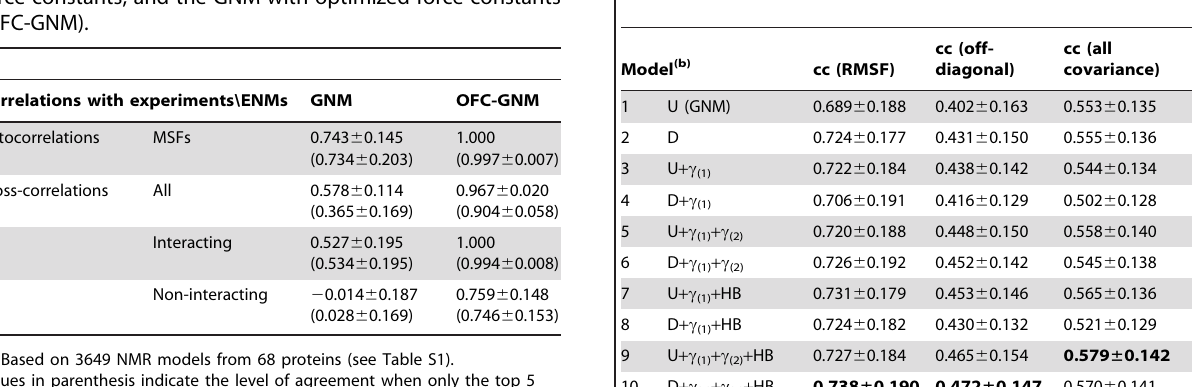
Table 3. Correlations between various ENM-predicted covariances and those observed in NMR experiments (a) .